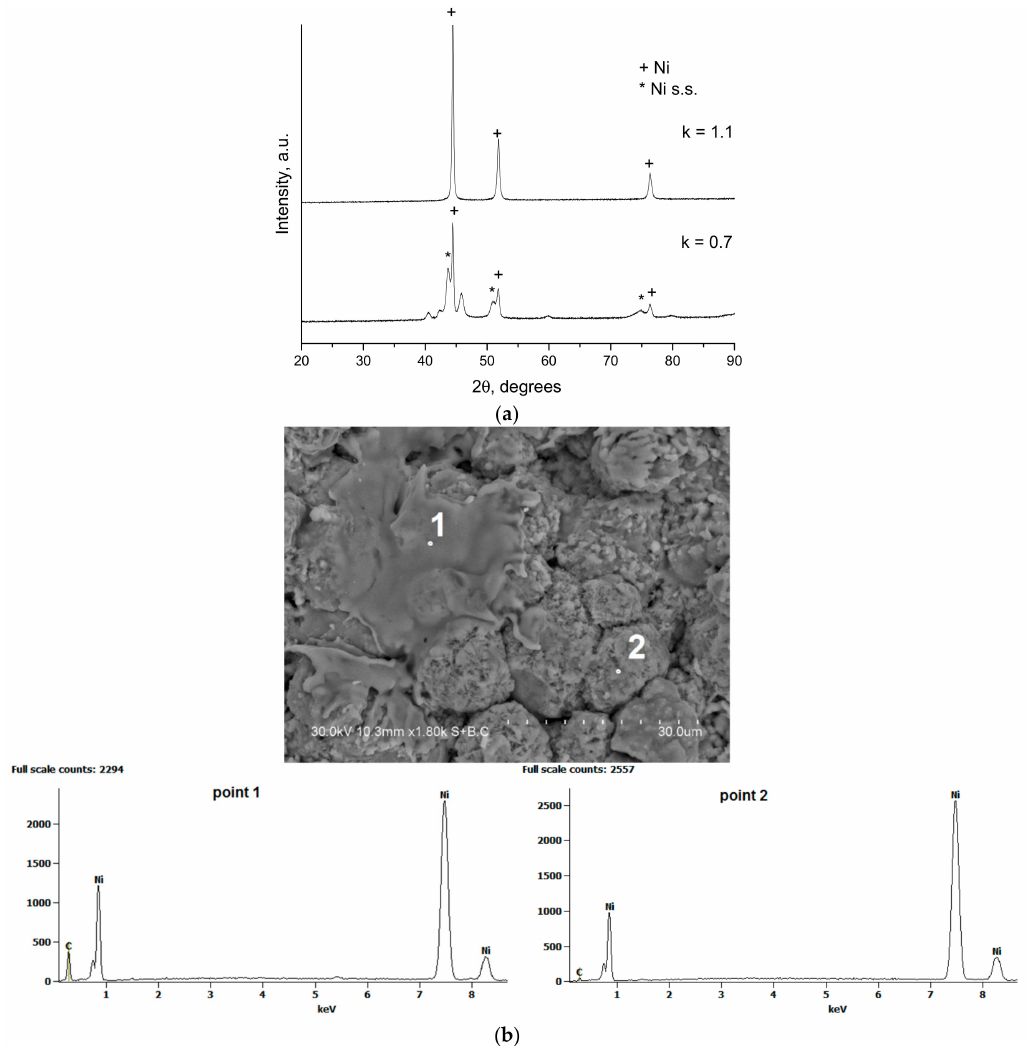
Figure 18. XRD patterns taken from the surface of detonation coatings obtained from a nickel powder at k = 0.7 and k = 1.1, explosive charge 50% ( a ); regions of the surface of the coatings obtained at k = 0.7 resolidified (marked 1) and deposited in the solid state (marked 2) and energy-dispersive spectra (EDS) from the corresponding points ( b ). ((b) is reprinted from [53], Copyright (2016), with permission from